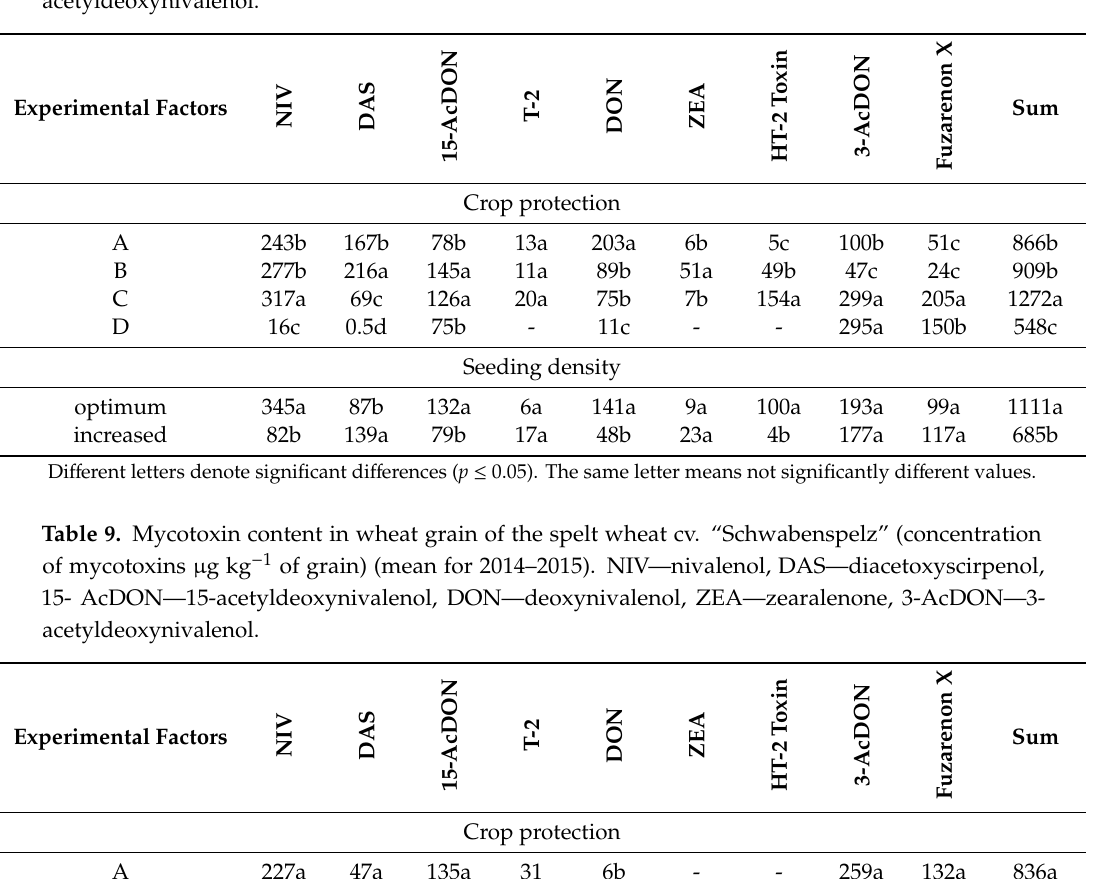
Table 8. Mycotoxin content in wheat grain of the spelt wheat cv. “Rokosz” (concentration of